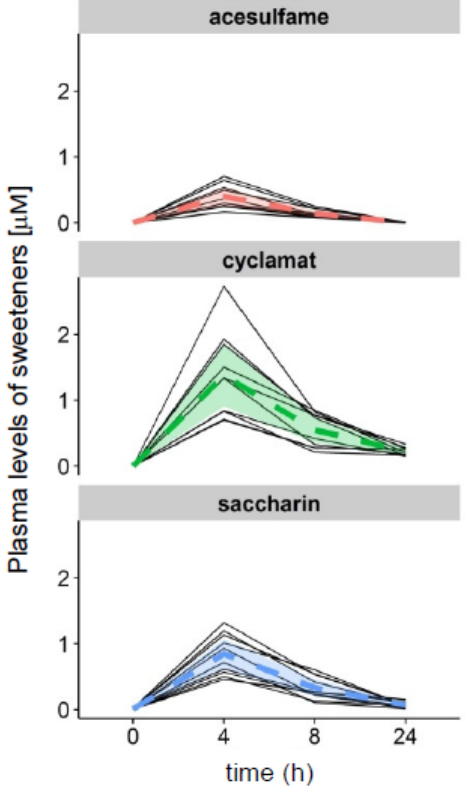
Figure 3. Intervention-derived plasma kinetics of sweeteners in healthy volunteers. Ten volunteers consumed a surrogate beverage containing soft drink-typical concentrations of acesulfame-K, cyclamate, and saccharin dissolved in mineral water (compare Figure 1, Table 1). The appearance of the sweeteners in the plasma was monitored by HPLC-MS/MS over 24 h, as indicated by the time intervals on the X -axis. Black lines, individual plasma concentrations of sweeteners; colored dashed line, mean ( n = 10); colored areas, 95% confidence intervals.